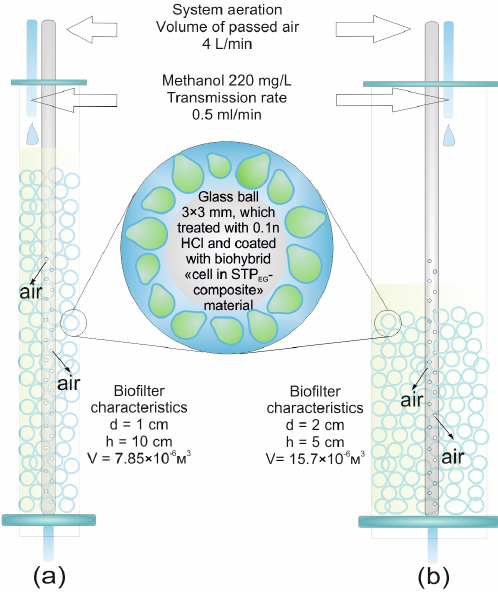
Figure 9. Operational guidelines for trickling biofilter columns: biofilter bed—glass beads of 3.3 mm in diameter with surfaces modified with encapsulated yeast cells; test conditions: biological treatment of wastewater with a methanol concentration of 220 mg/L in ( a ) a long column or ( b ) a short column.